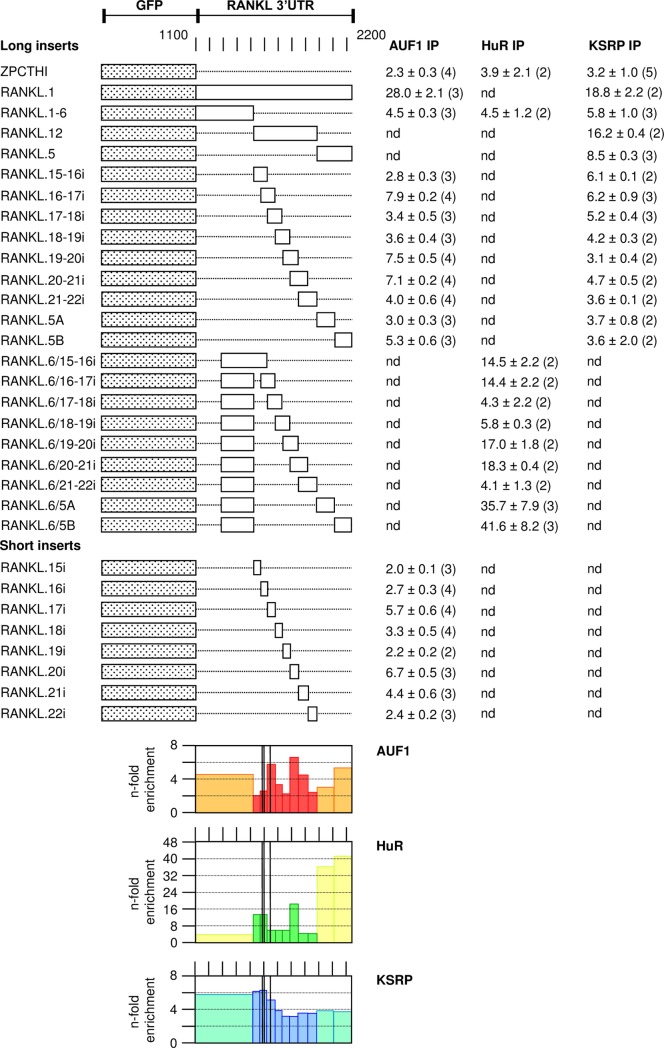
Binding-sites for AUF1 p37, HuR and KSRP in the mouse RANKL 3’UTR.Various pZPCTHI constructs with long or short inserts of the 3’UTR of mouse RANKL mRNA were transiently transfected with Lipofectamine 2000 into HEK 293T cells along with vectors to express tagged ARE-binding proteins. 21 h post transfection, cells were lysed and protein-bound RNA co-immunoprecipitated and recovered as shown in Fig 1 and described in Materials and Methods. RNA was isolated from input, microbead-adsorbed pellet and non-bound supernatant fractions, and EGFP and endogenous GAPDH mRNA quantified by RT-PCR. For each recombinant ARE-binding protein, the % adsorbed versus totally recovered RNA was calculated, and the relative enrichment of EGFP mRNA versus GAPDH mRNA expressed as “n-fold enrichment” ± standard deviation (number independent experiments). The graphs below show a graphical representation of the results. Vertical black bars indicate the location of instability elements.